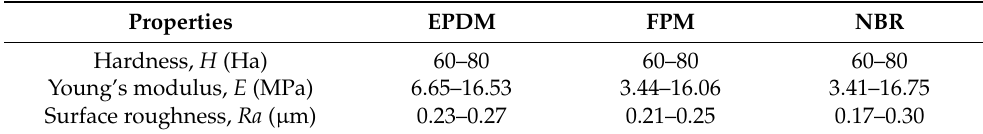
Table 1. Material properties of rubber samples.